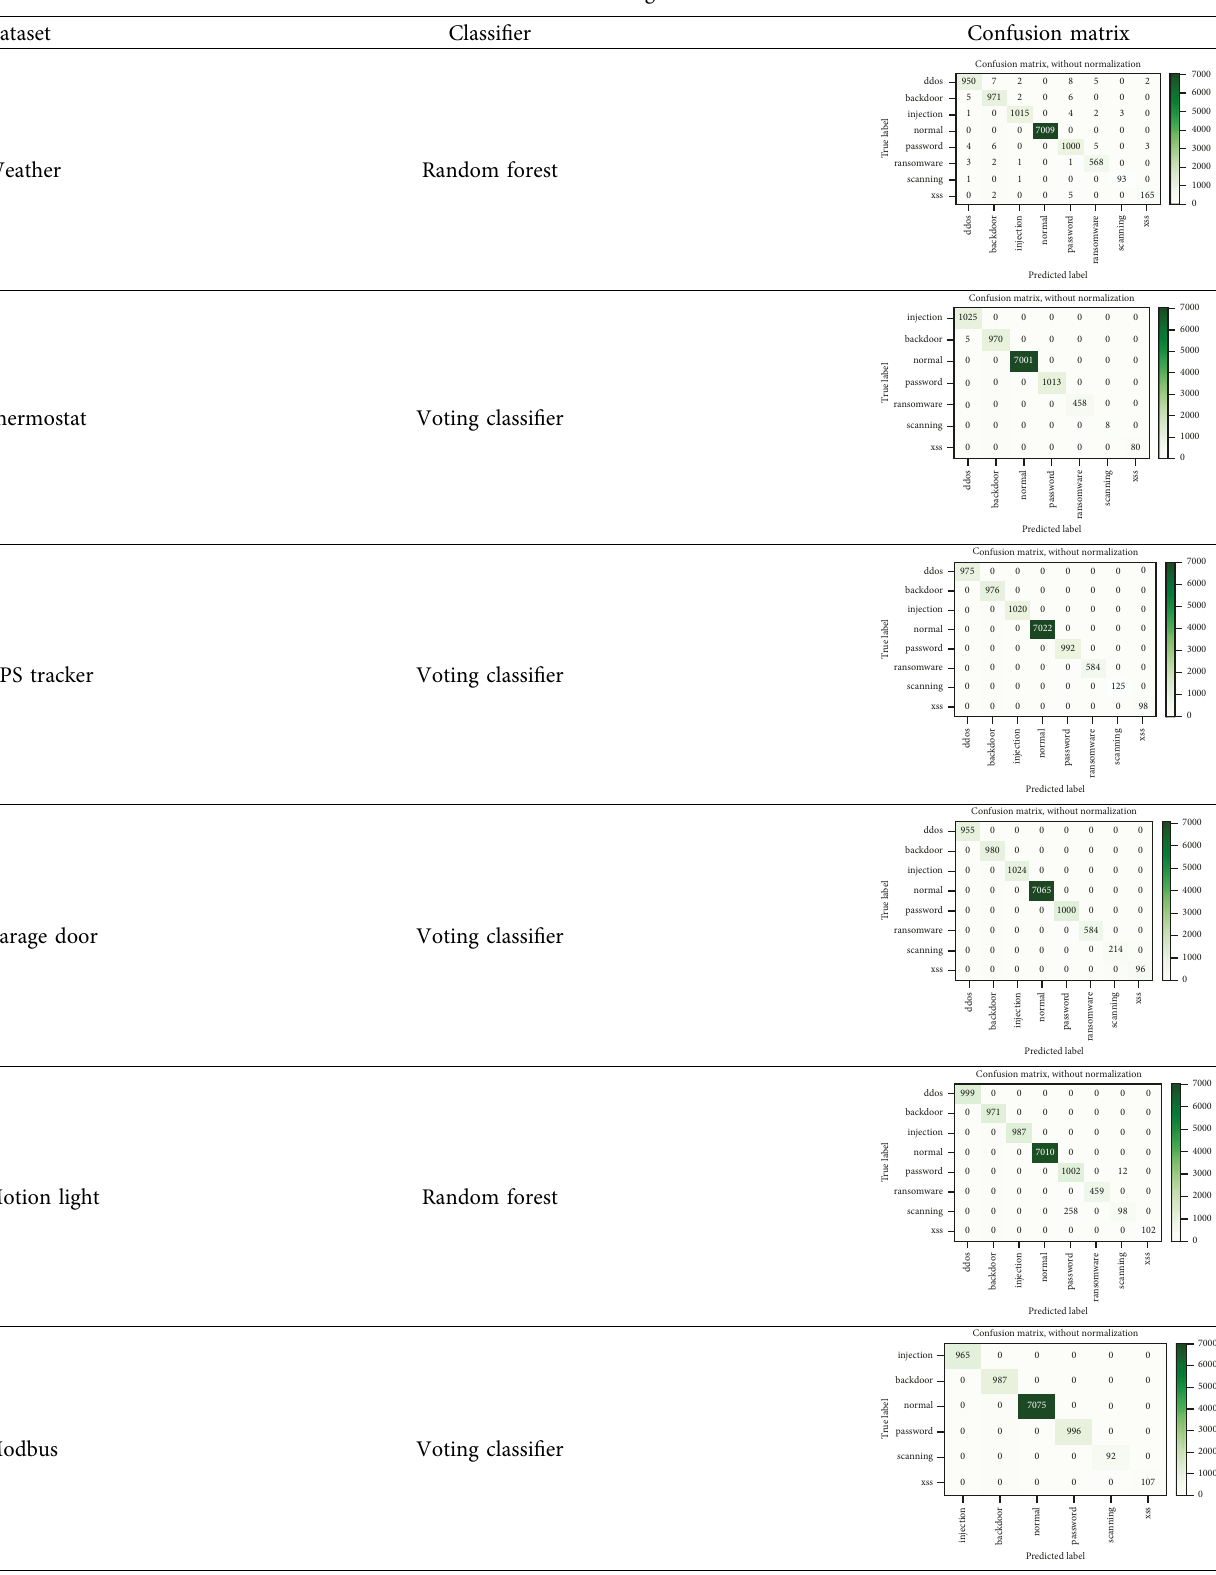
Table 6: Confusion matrix against each